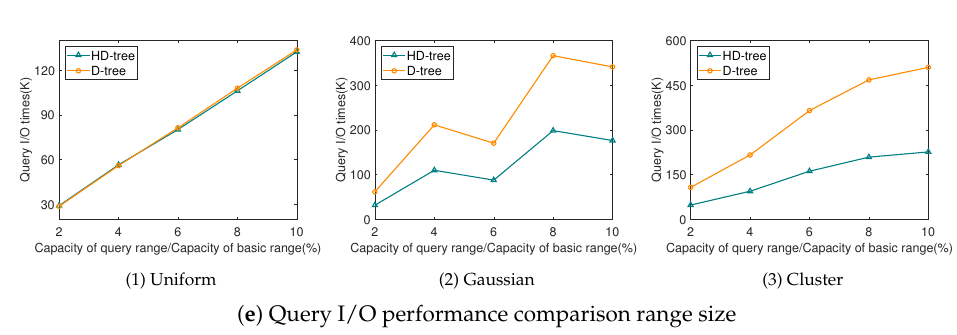
Figure 6. Experimental